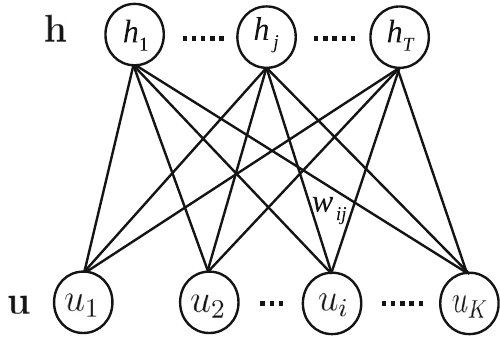
Fig. 2 Restricted Boltzmann machine